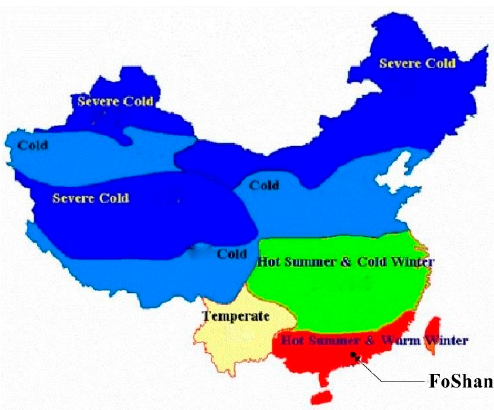
Figure 3. The detailed climate region of Fo Shan.